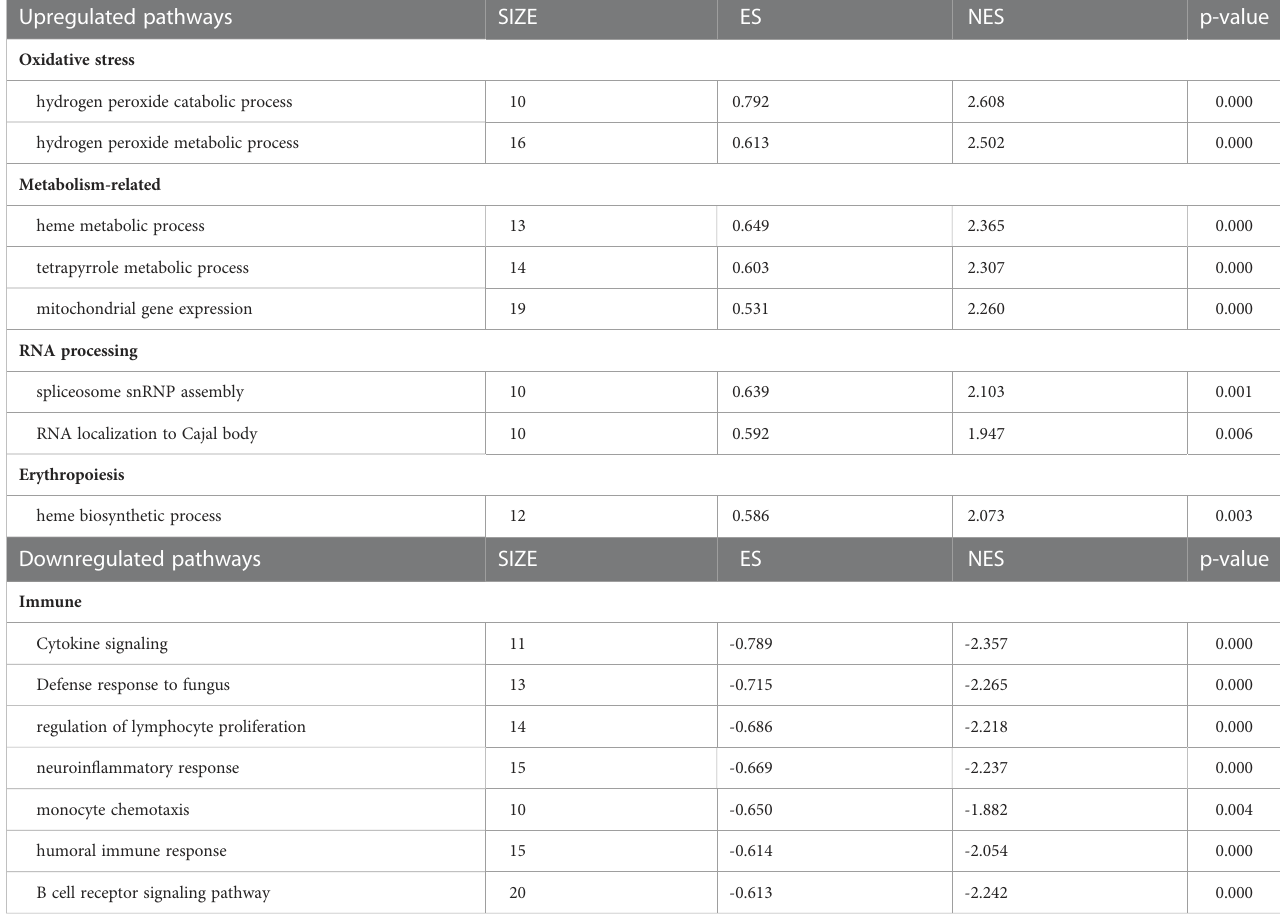
TABLE 2 GSEA enriched pathways in HSC/CMP population.